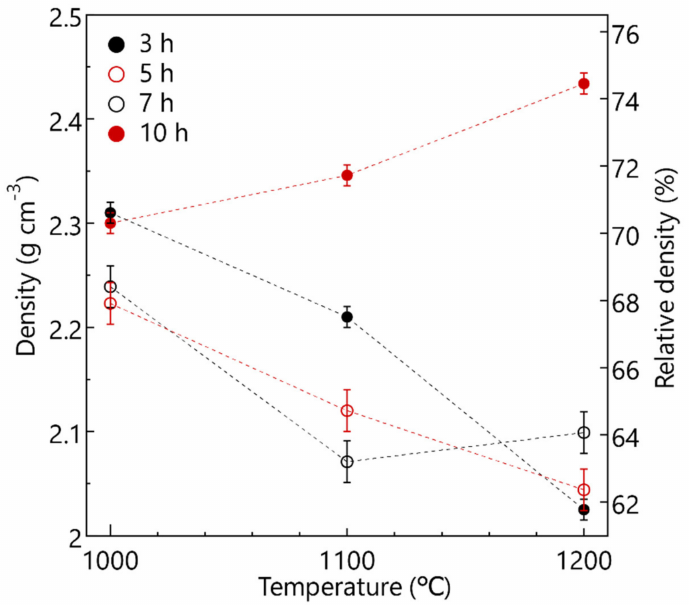
Figure 5. Bulk density and relative density of the LPS-NZSP as a function of calcination